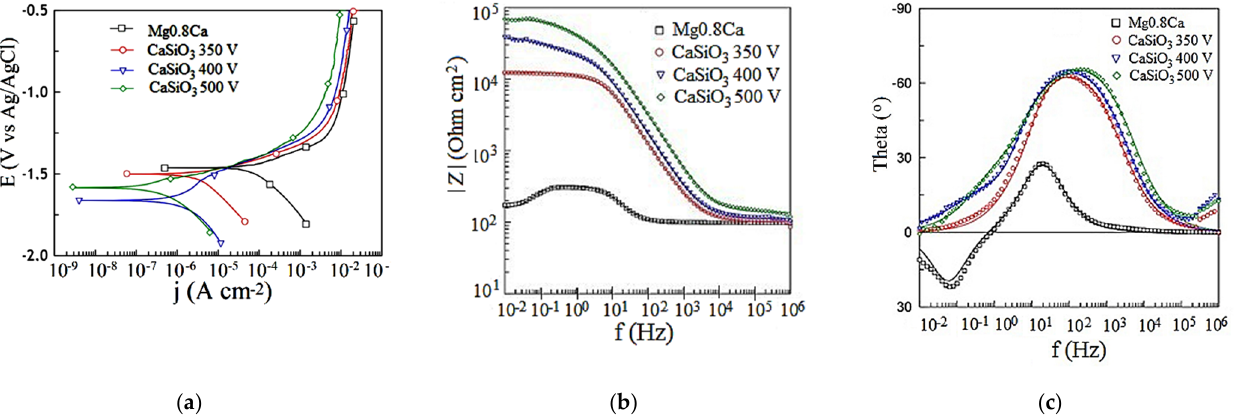
Figure 13. Potentiodynamic polarization (PDP) curves ( a ), Bode plots (the impedance modulus |Z| ( b ) and the phase angle theta on the frequency ( c ) dependencies) obtained in 0.9% NaCl for the bare Mg0.8Ca alloy and the W-coatings. Table 2. Electrochemical parameters of the bare Mg0.8Ca alloy and the W-coatings. Sample